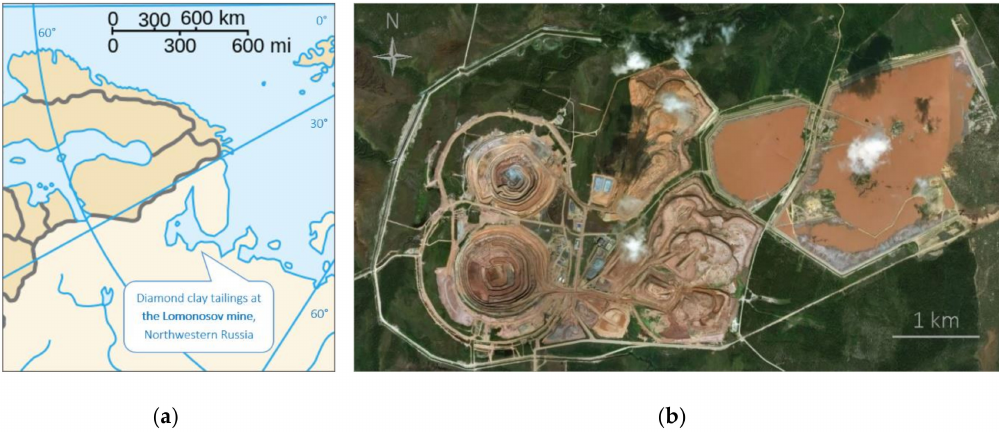
Figure 1. Study area: ( a ) the Lomonosov deposit in Arkhangelsk Oblast (based on the free blank map, commons.wikimedia.org); ( b ) waste rock dumps and tailings storage facilities eastwards of the open-pit mines at the Arkhangelskaya and Karpinskogo-1 pipes (based on the Bing satellite